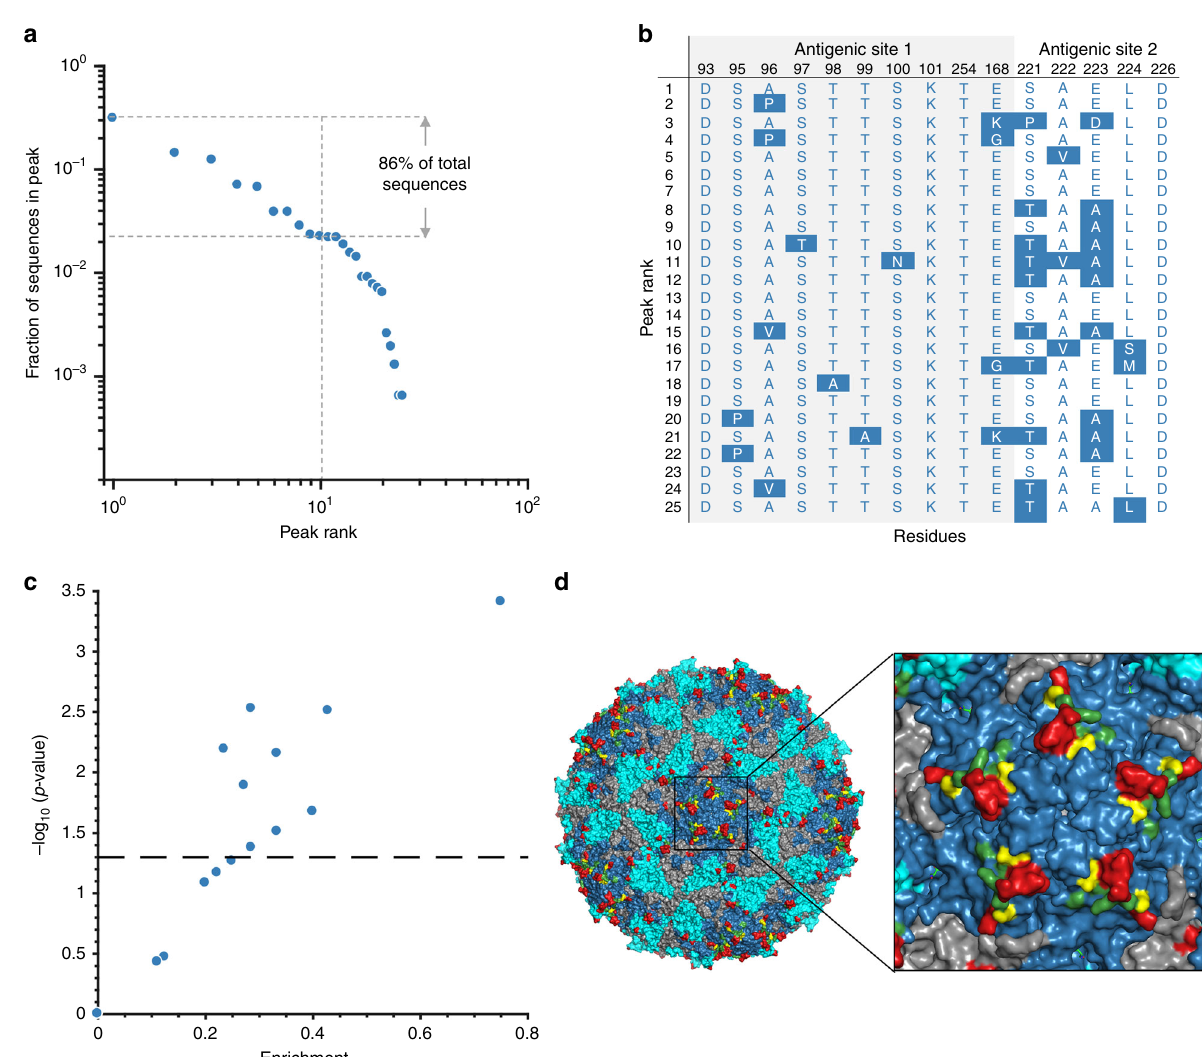
Fig. 2 Local peaks in the prevalence landscape of vp1 protein and their antigenic analysis. a The fraction of MSA sequences in each peak of the vp1 prevalence landscape versus rank on a log – log scale. b A large number of the peak sequences (16 out of 25) are enriched in mutations on the antigenic sites of vp1. These include the residues 93, 95 – 101, 254, 168, 221 – 223, 224, and 226, which are indicated in black in the top row. The combination of amino acids at antigenic sites of each peak sequence is shown in blue and the mutations compared to the consensus sequence represented in blue shaded blocks. Note that we focus here on the peak sequences only as they are a good representative of the antigenic makeup of the associated MSA sequences (Supplementary Fig. 10). c Out of the 16 peak sequences with mutations on antigenic sites, 10 (56%) peak sequences have statistically signi fi cant results (for p -value calculation, see the “ Methods ” section). Enrichment values are de fi ned as the number of antigenic mutations in a peak sequence divided by the total number of mutations observed in that peak sequence. The black dotted horizontal line is the cut-off for statistically signi fi cant results ( p < 0.05), with all the peak sequences above this line being classed as statistically signi fi cant. d Prediction of novel antigenic residues in vp1 protein. The biological assembly of the complete capsid protein of PV (PDB ID: 2PLV) consists of 60 copies each of vp1, vp2, vp3, and vp4 proteins. Out of these four proteins, vp1, vp2, and vp3 are on the surface of the virus as indicated by blue, cyan, and gray colors respectively. The mutations observed in the known antigenic sites 31 in the peak sequences are shown in red (residues 95 – 100, 168, and 221 – 224) while the remaining ones (residues 93, 101, 254, and 226) are shown in green. The neighboring residues of Ags1 (residues 169, 252, and 257) that were observed to have mutations in the peak sequences are shown in